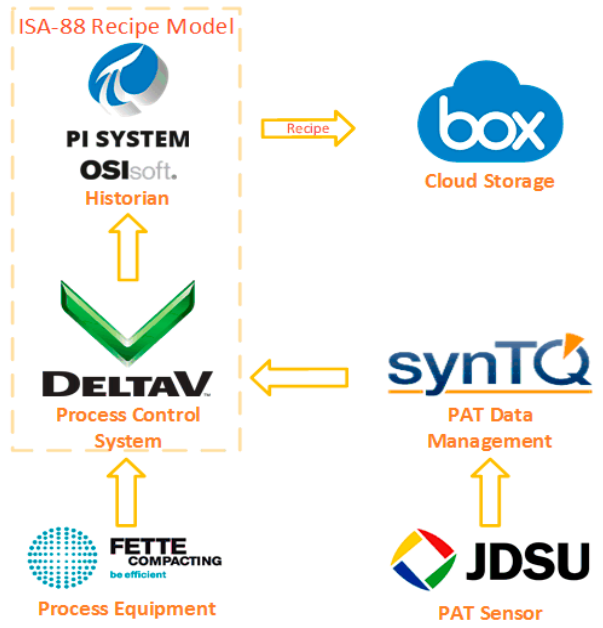
Figure 8. Data flow in continuous tablet manufacturing.